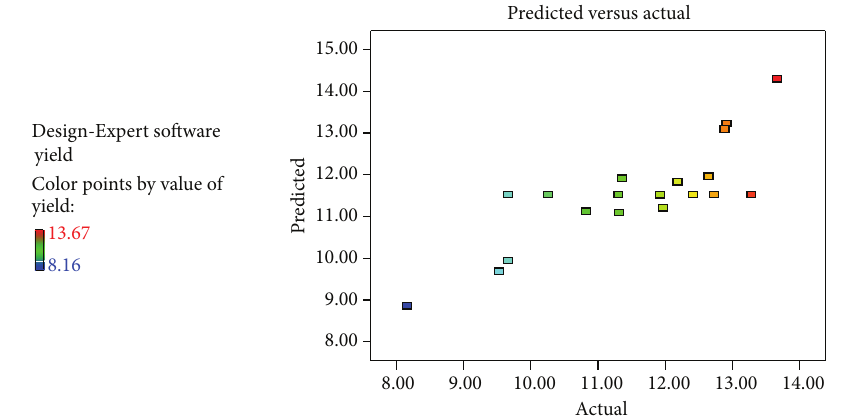
Figure 1: Correlation between predicted and experimental values of the yield of Tinospora